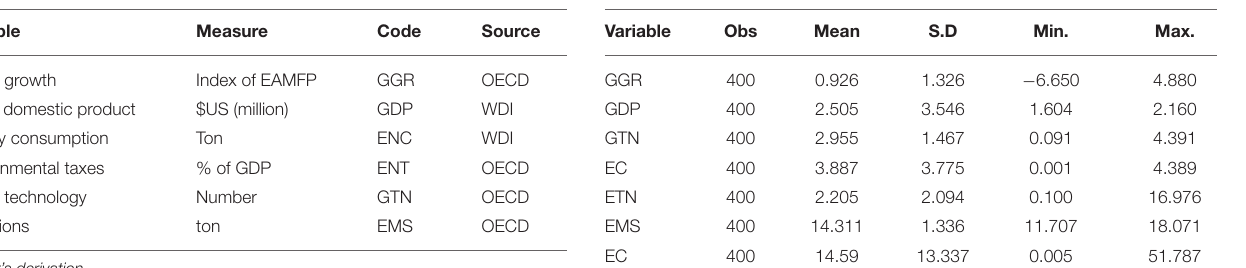
TABLE 1 | Variables, measure, and